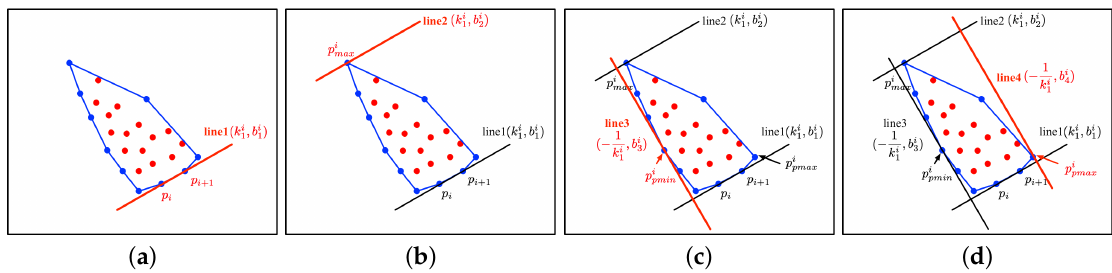
Figure 2. The determination process of the bounding box. ( a – d ) indicate the determination process of line 1 to line 4, respectively. The dots denote the point-clouds. The polygon represented by the blue lines denote the convex hull of this set of